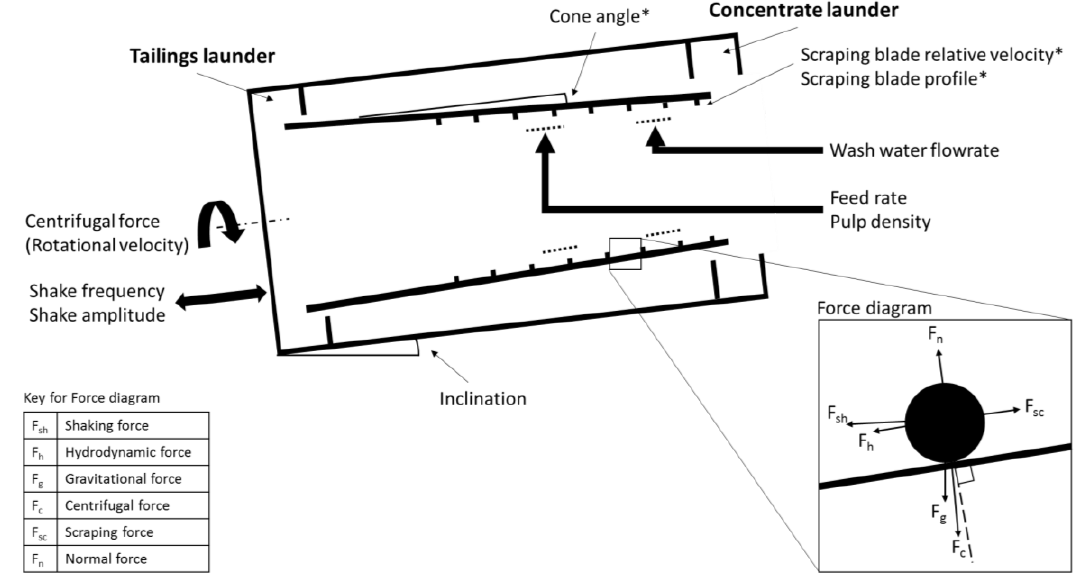
Figure 2. MGS operating and design (denoted with *) variables and principle forces (Force Diagram modified after [4]).